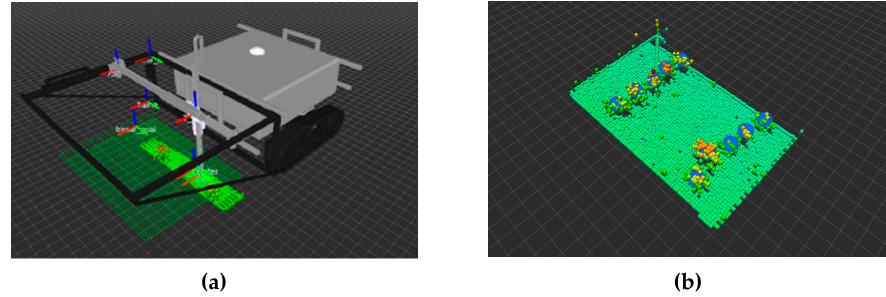
Figure 2. Visualization of the robot system ( a ) and the acquired point cloud in ROS-rviz, with the estimated plant positions by the software algorithm (blue dots) ( b ).